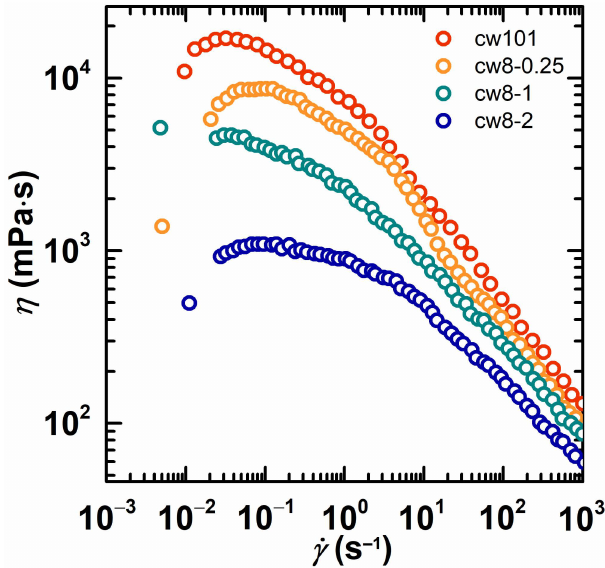
Figure 6. The apparent viscosity as a function of the shear rate for cw101 and cw8 with different hydrophobe concentrations. The copolymer concentration was fixed at 2 wt% in all